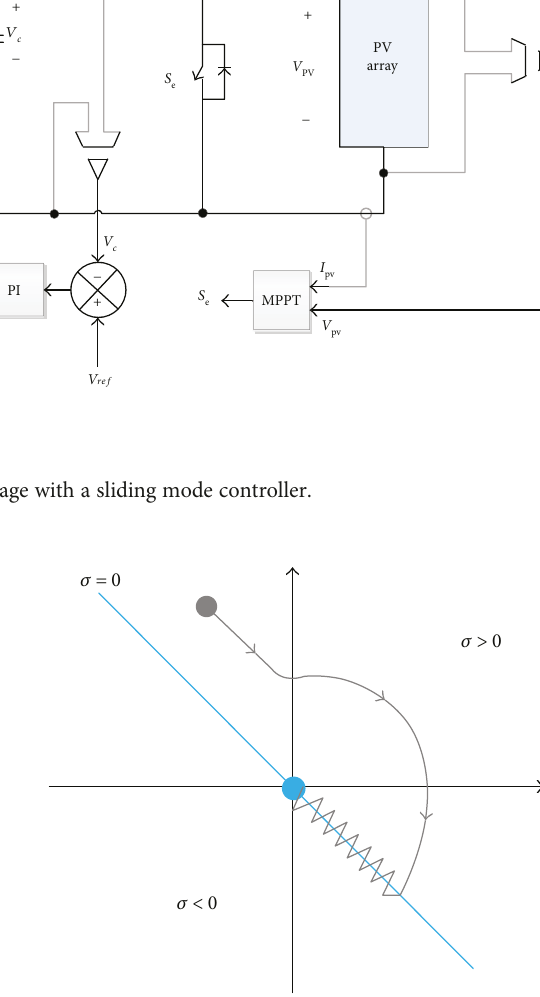
Figure 2: Evolution of the system with a sliding mode